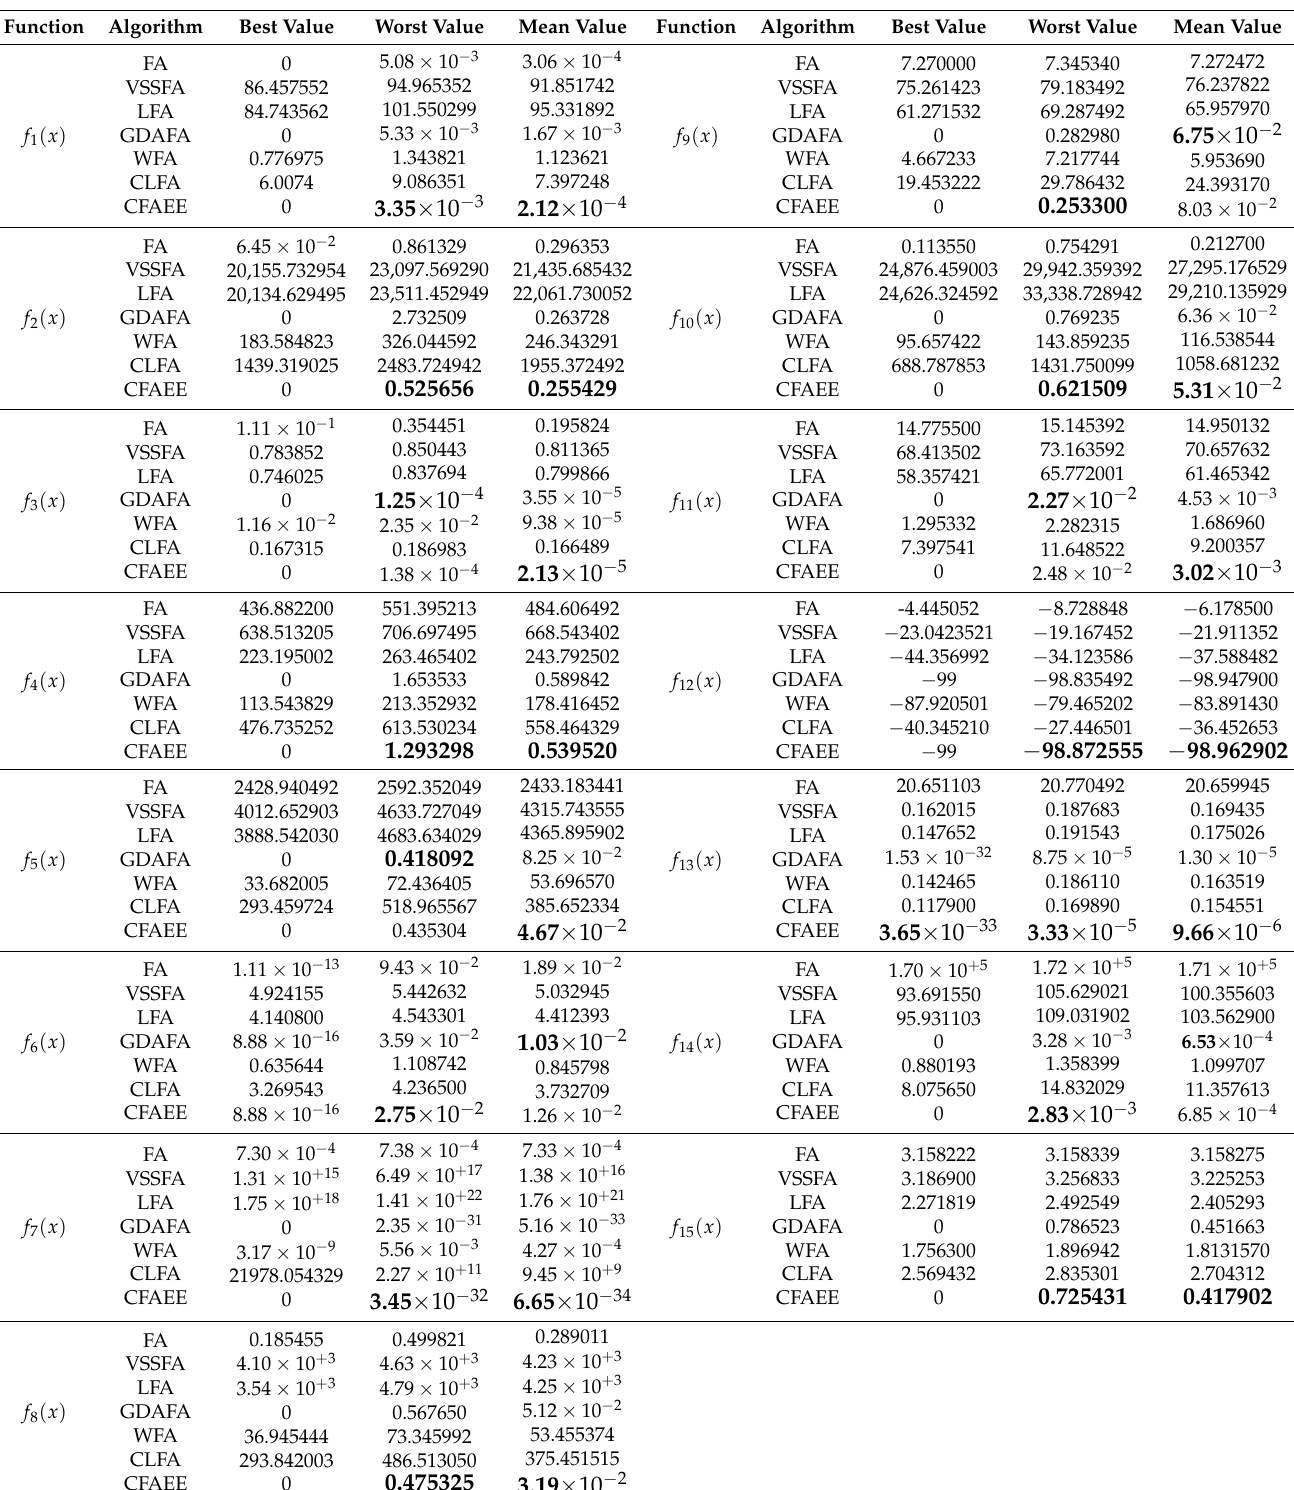
Table 5. Comparative analysis among CFAEE, original FA, and five other FA implementations for benchmarks with 100